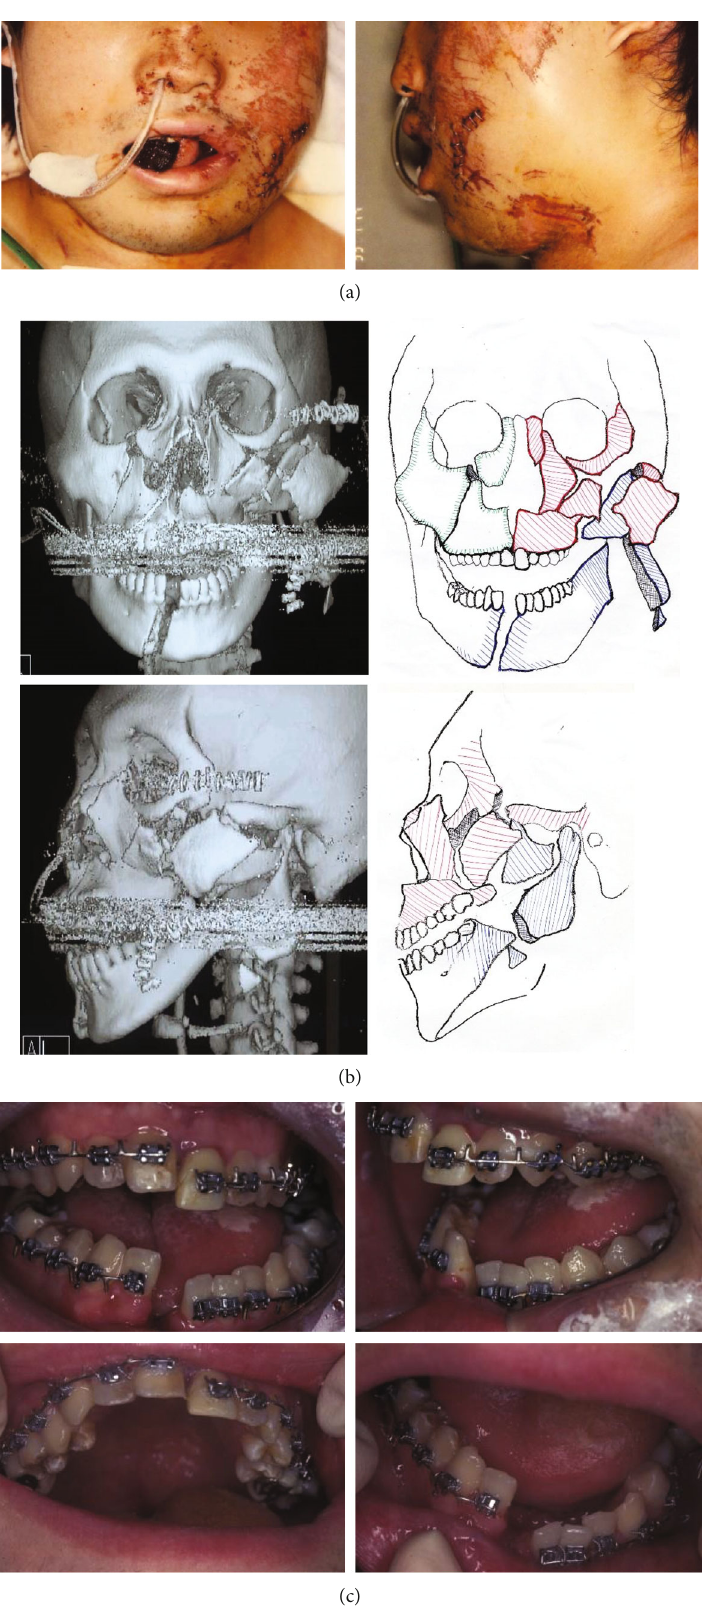
Figure 1: Facial photographs (a) and cephalic CT images with schematic illustrations immediate after injury (b) and intraoral photographs taken after placement of surgical braces for the intermaxillary fi xation